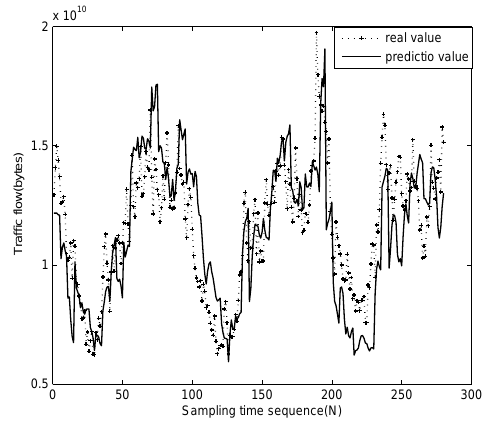
Figure 4. Comparison between the real and prediction traffic in five-steps